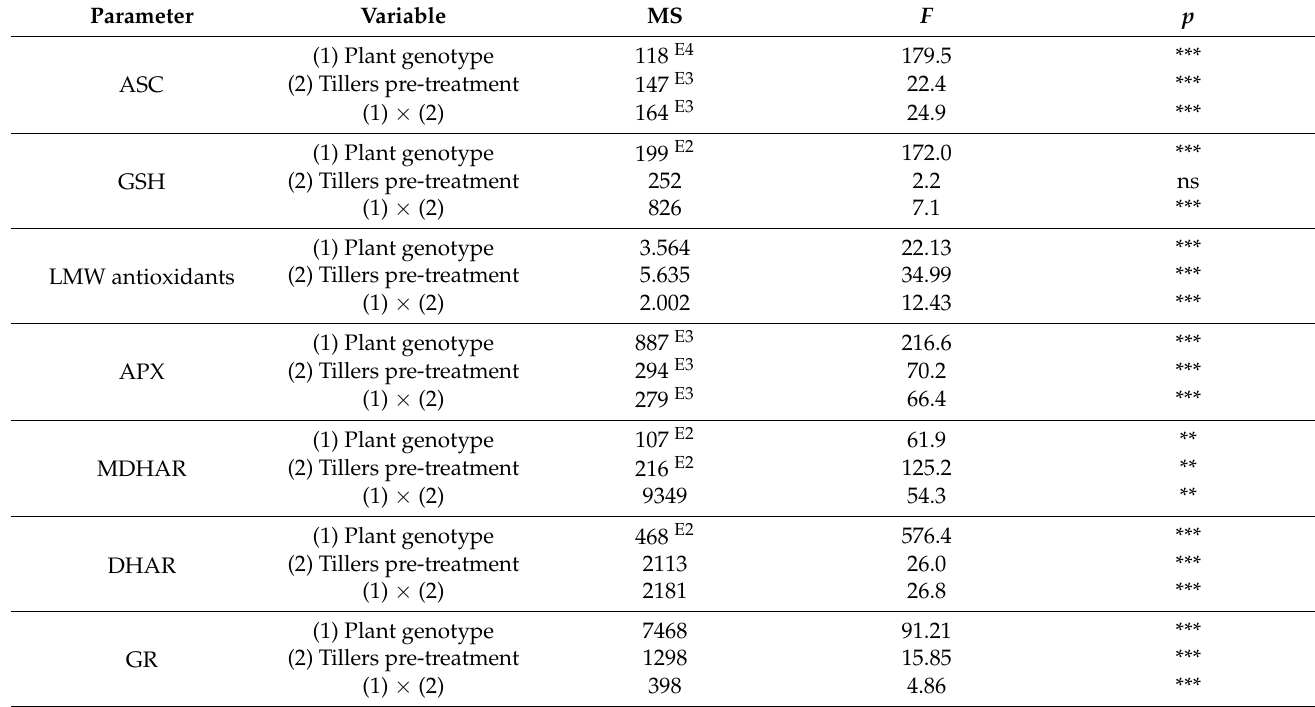
MS—mean squares, an estimate of variance of a variable or interaction between variables; F — F calculated as variance of a variable or interaction between variables divided by error variance of the experiment; p —error probability for rejection of the null hypothesis about the significance of variability within a variable or interaction between variables: ***, **, ns—significant at p ≤ 0.001, p ≤ 0.01, not significant, respectively; E—scientific notation (times ten raised to the power of two, three,